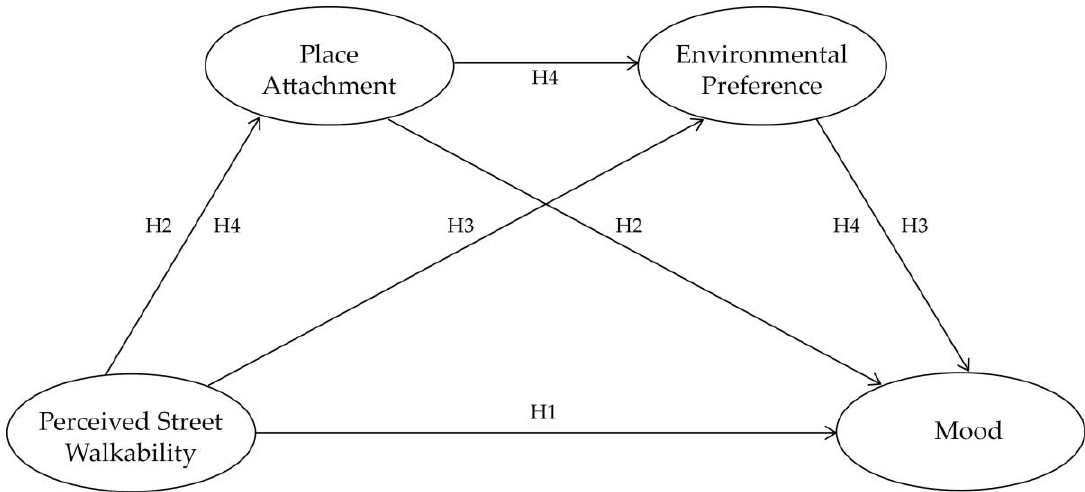
Figure 1. Theoretical framework of the relationship between perceived street walkability and the mood of the elderly, with place attachment and environmental preference as mediators.